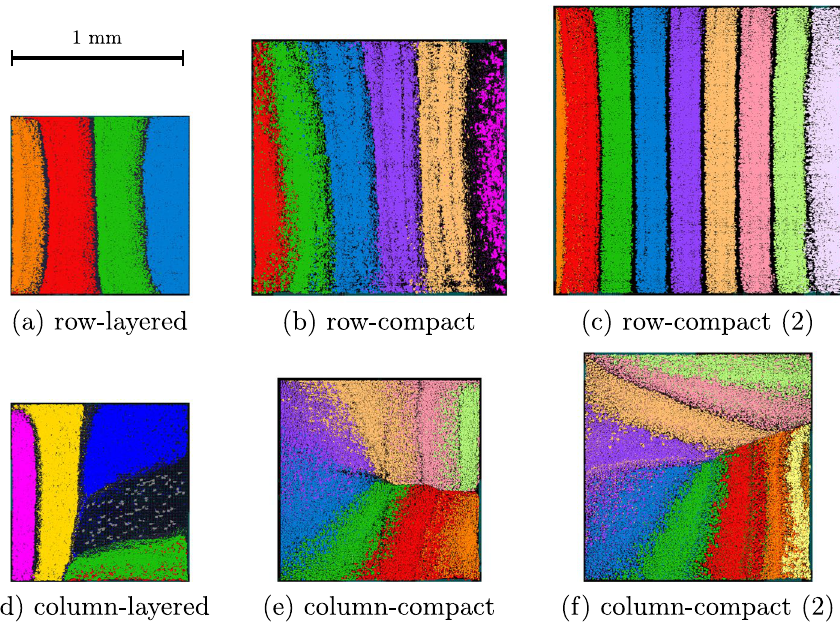
Table 1 Implementation results in 22nm FD-SOI technology